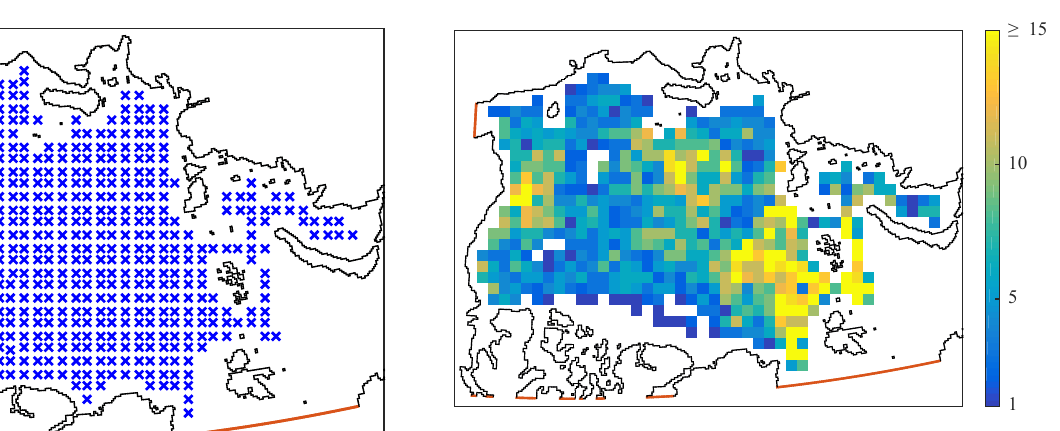
Figure 4. Spatial distribution of the number of occurrences of free- drift events between 1 January and 30 April 2008. The temporal sampling frequency used is 1 day. These are the instances used for the optimisation of the air drag